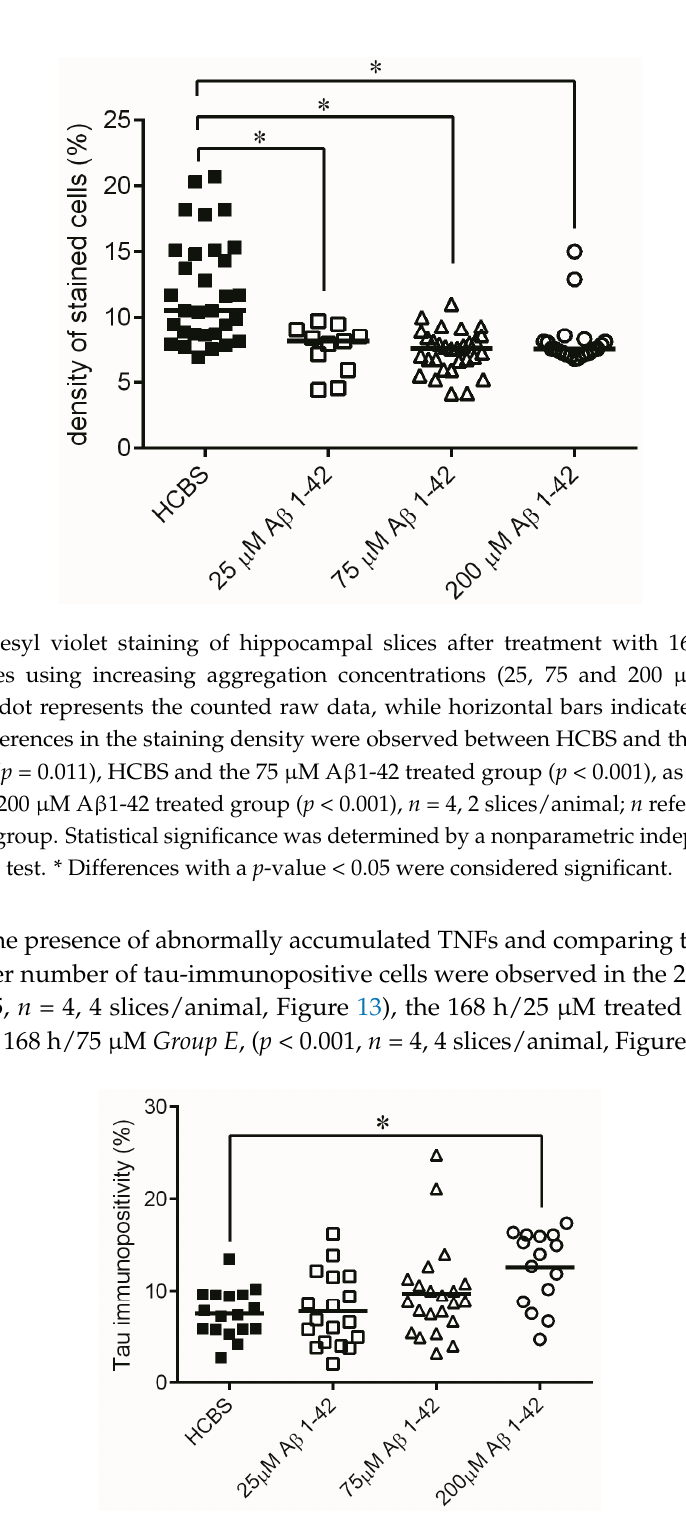
Figure 13. Tau-immunostaining of hippocampal slices after treatment with 24 h aggregated oA β assemblies using increasing aggregation concentrations (25, 75 and 200 µ M) of A β 1-42 treatment. Each dot represents the counted raw data, while horizontal bars indicate mean values. Significant difference in the number of tau-immunopositive cells were observed only between the HCBS and the 200 µ M A β 1-42 treated group ( p = 0.015, n = 4, 4 slices/animal; n refers to the number of animals per group) Statistical significance was determined by one-way ANOVA, followed by Hochberg’s GT2 post hoc test. * Differences with a p -value < 0.05 were considered